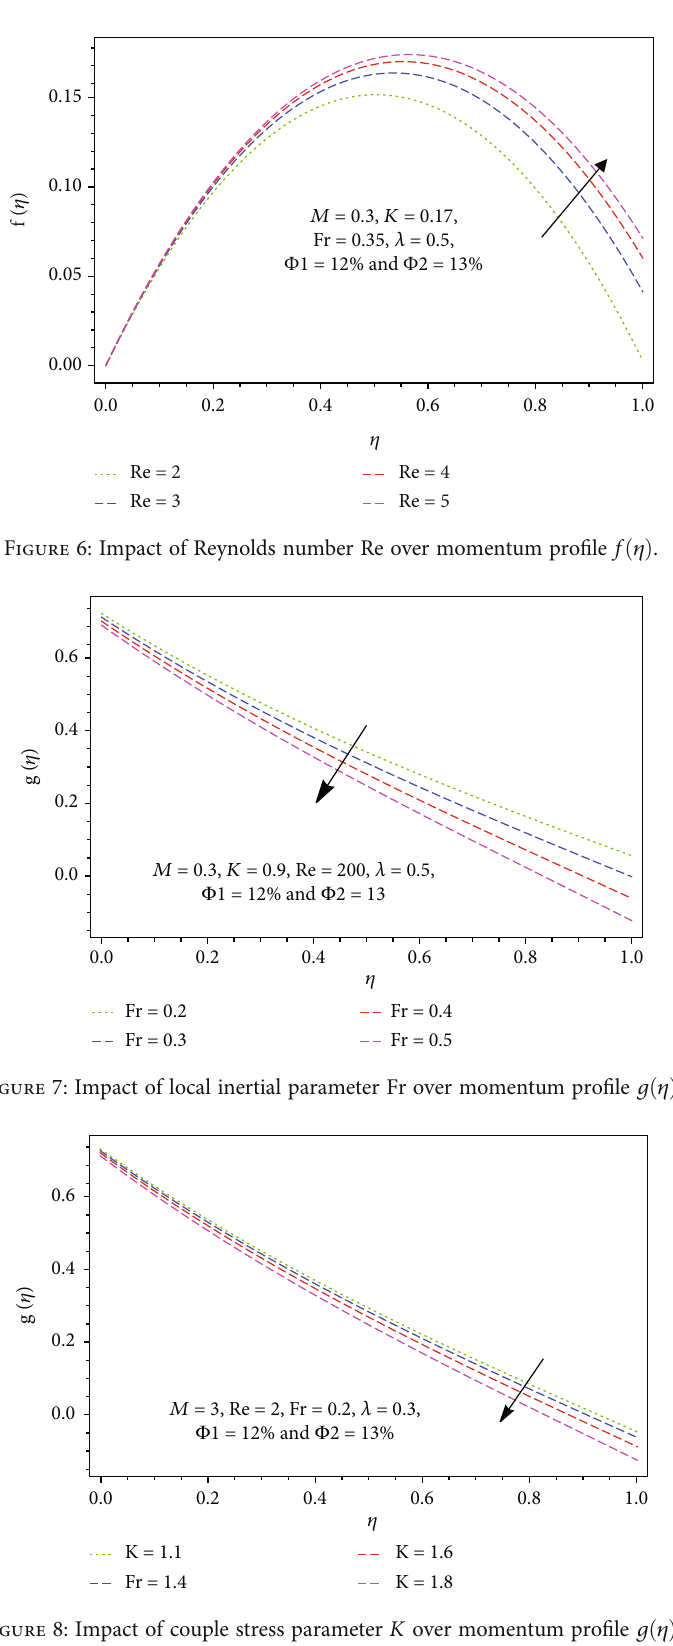
Figure 8: Impact of couple stress parameter K over momentum pro fi le g ð η Þ